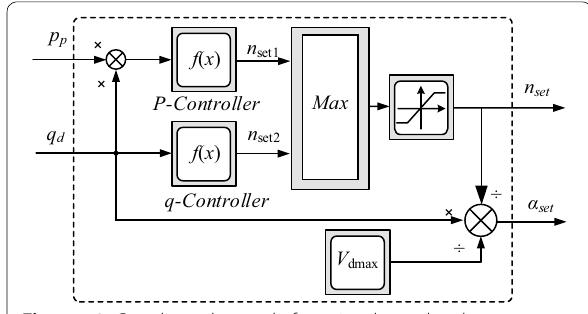
Figure 10 Coordinated control of rotational speed and